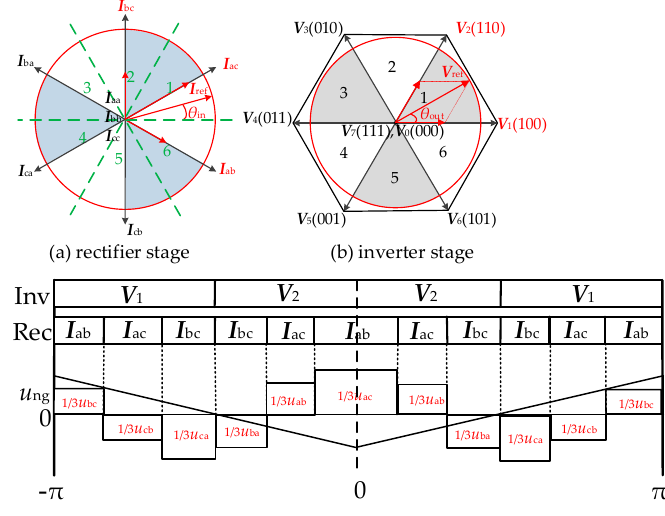
Figure 7. Modulation principle and vector distribution of method 3.